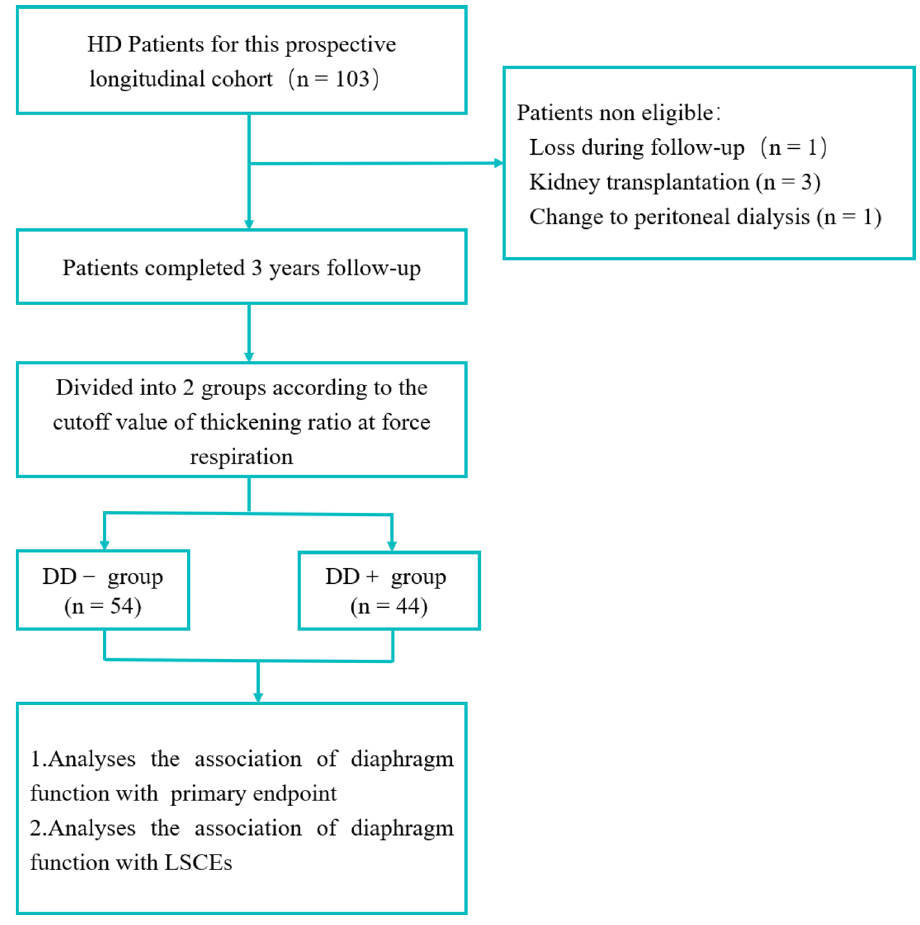
Figure 1. Flowchart of study